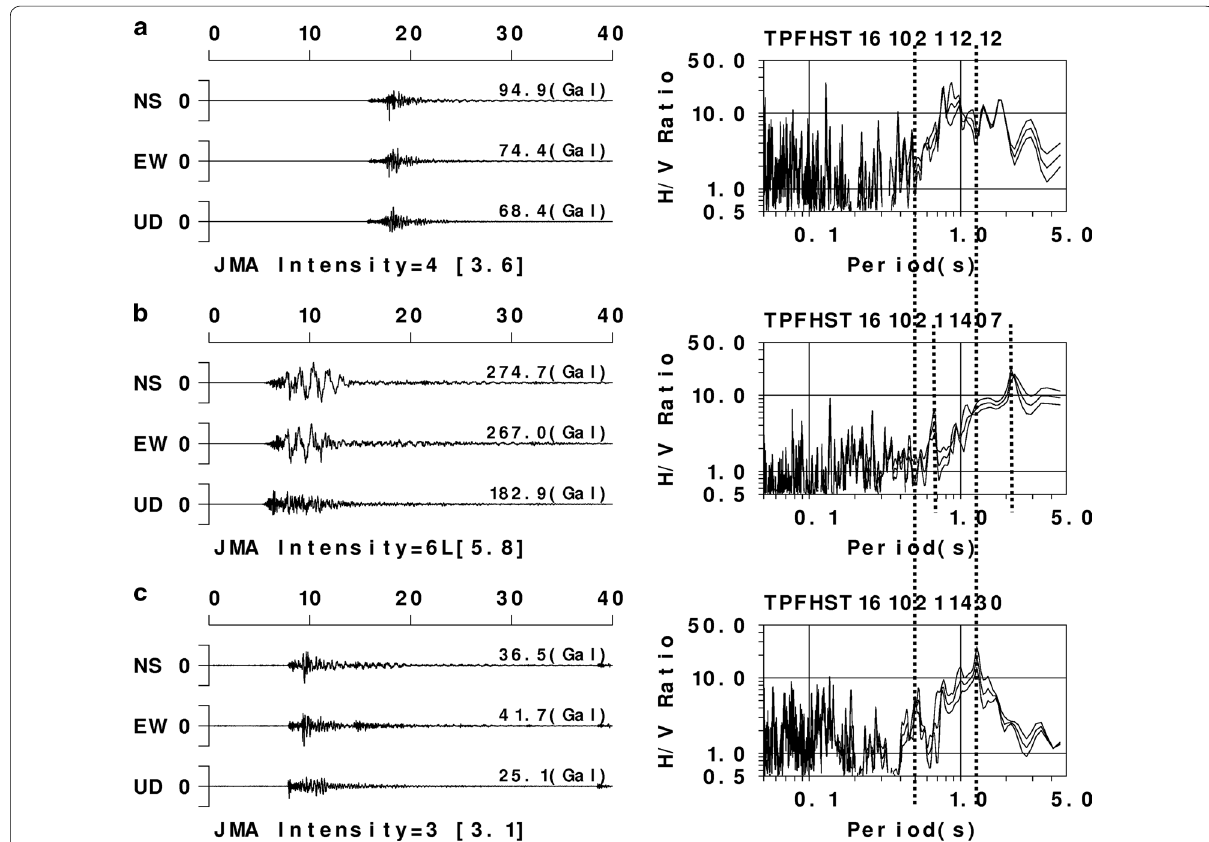
Fig. 4 Observed accelerations for the a foreshock at 12:12 JST, b main shock at 14:07 JST, and c aftershock at 14:30 JST at the Hojo branch (Hashita, Hokuei Town). Details are same as Fig.